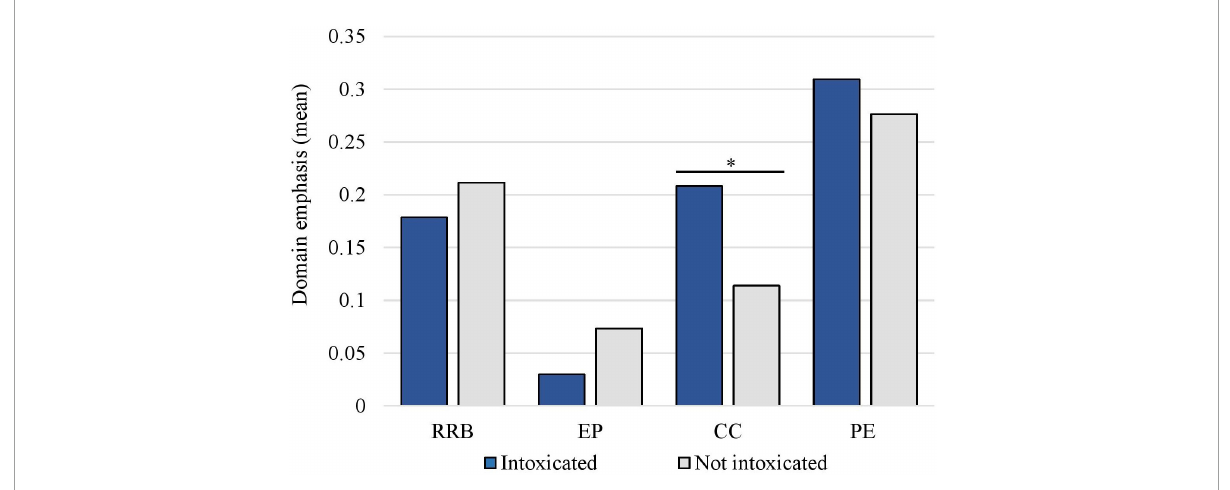
FIGURE1 The interrogators’ use of domains with suspects showing signs of intoxication versus not. RRB, rapport and relationship building; EP, emotion provocation; CC, confrontation/competition; PE, presentation of evidence. The domain emphasis scale ranged from 0 to 2 scores. *Significant difference between groups ( p = 0.042, η 2 = 0.02).